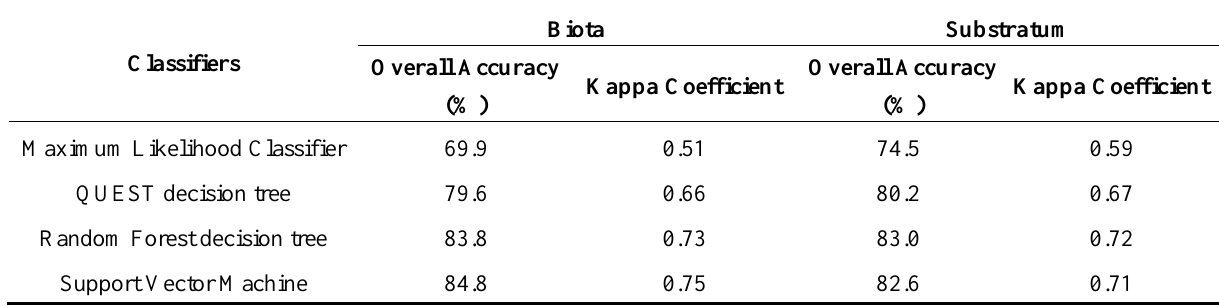
Table 1. Accuracy comparison from four different